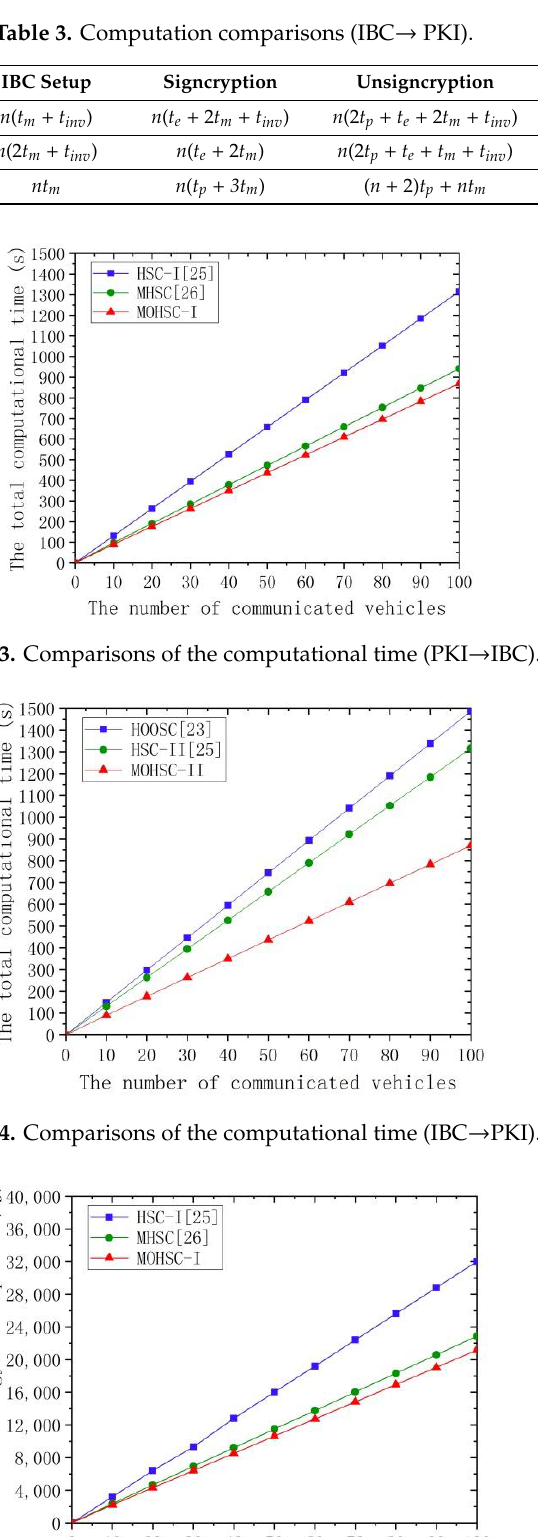
Figure 5. Comparisons of total energy consumption (PKI → IBC).